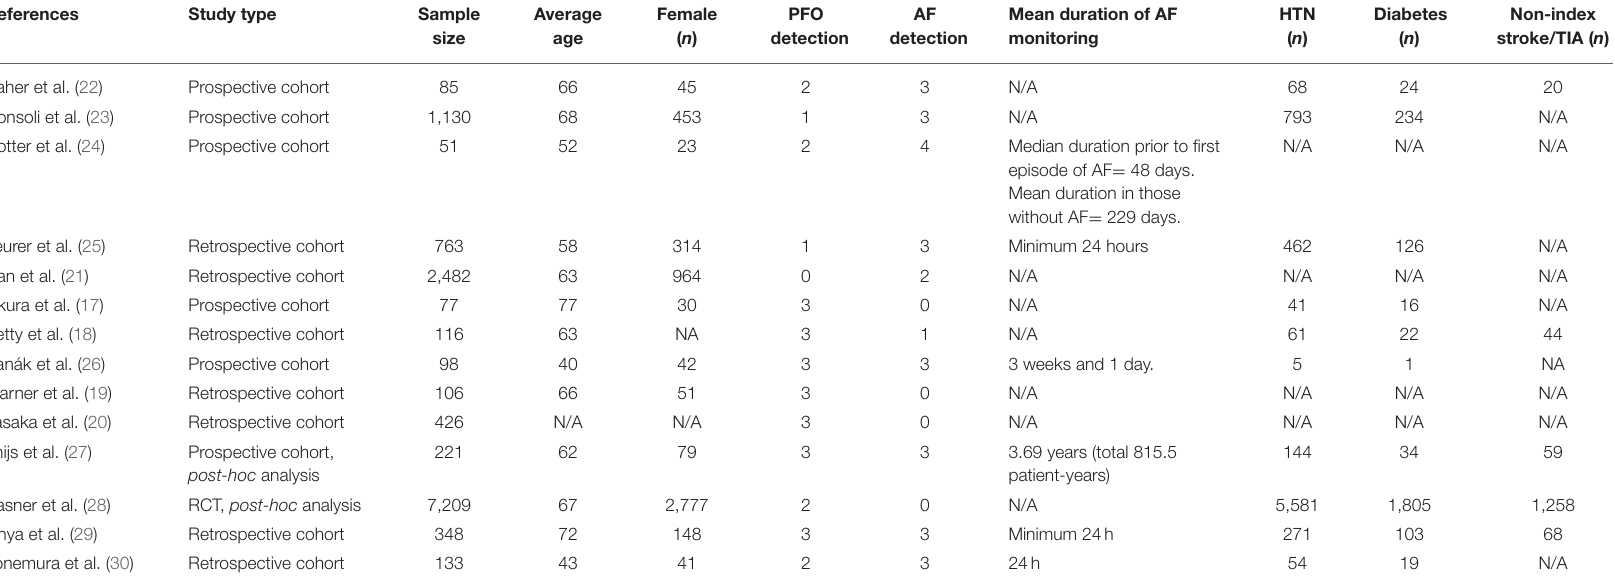
TABLE 1 | Study characteristics—risk of AF in those with PFO compared to those